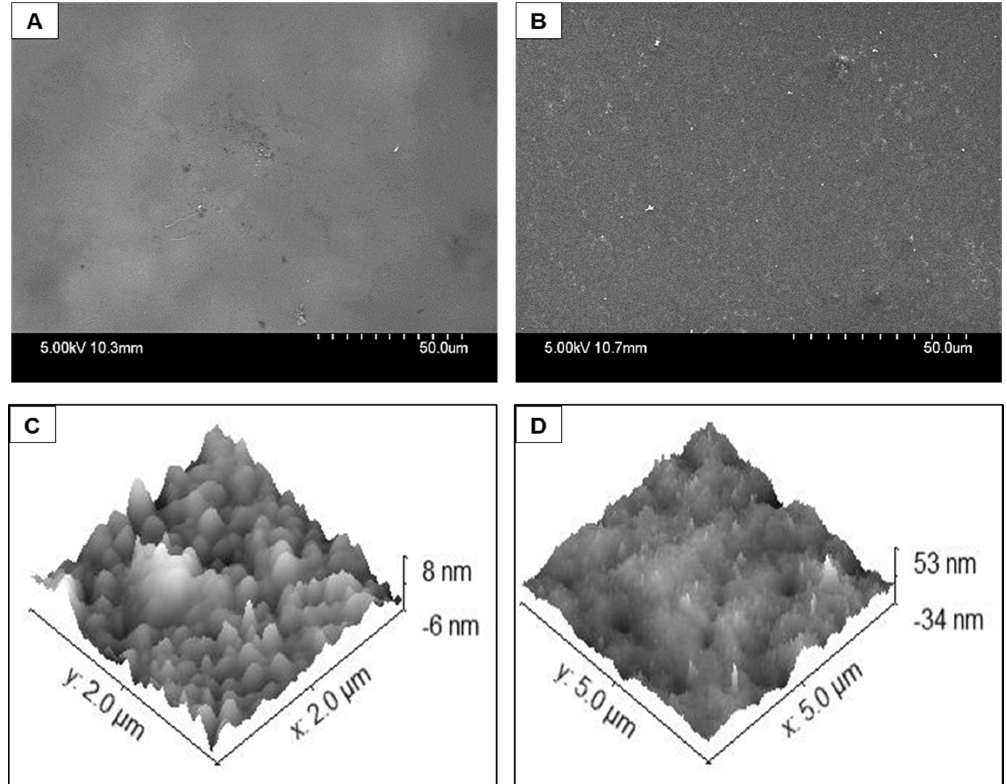
Figure 9. (top) Scanning Electron Microscopy (SEM) images of gold-coated silicon wafers with ( A ) plasma deposited rat tail collagen, ( B ) wet chemical deposition of rat tail collagen. (bottom) Atomic Force Microscopy (AFM) images of gold-coated silicon wafers with ( C ) plasma deposited rat tail collagen, ( D ) wet chemical deposition of rat tail collagen.